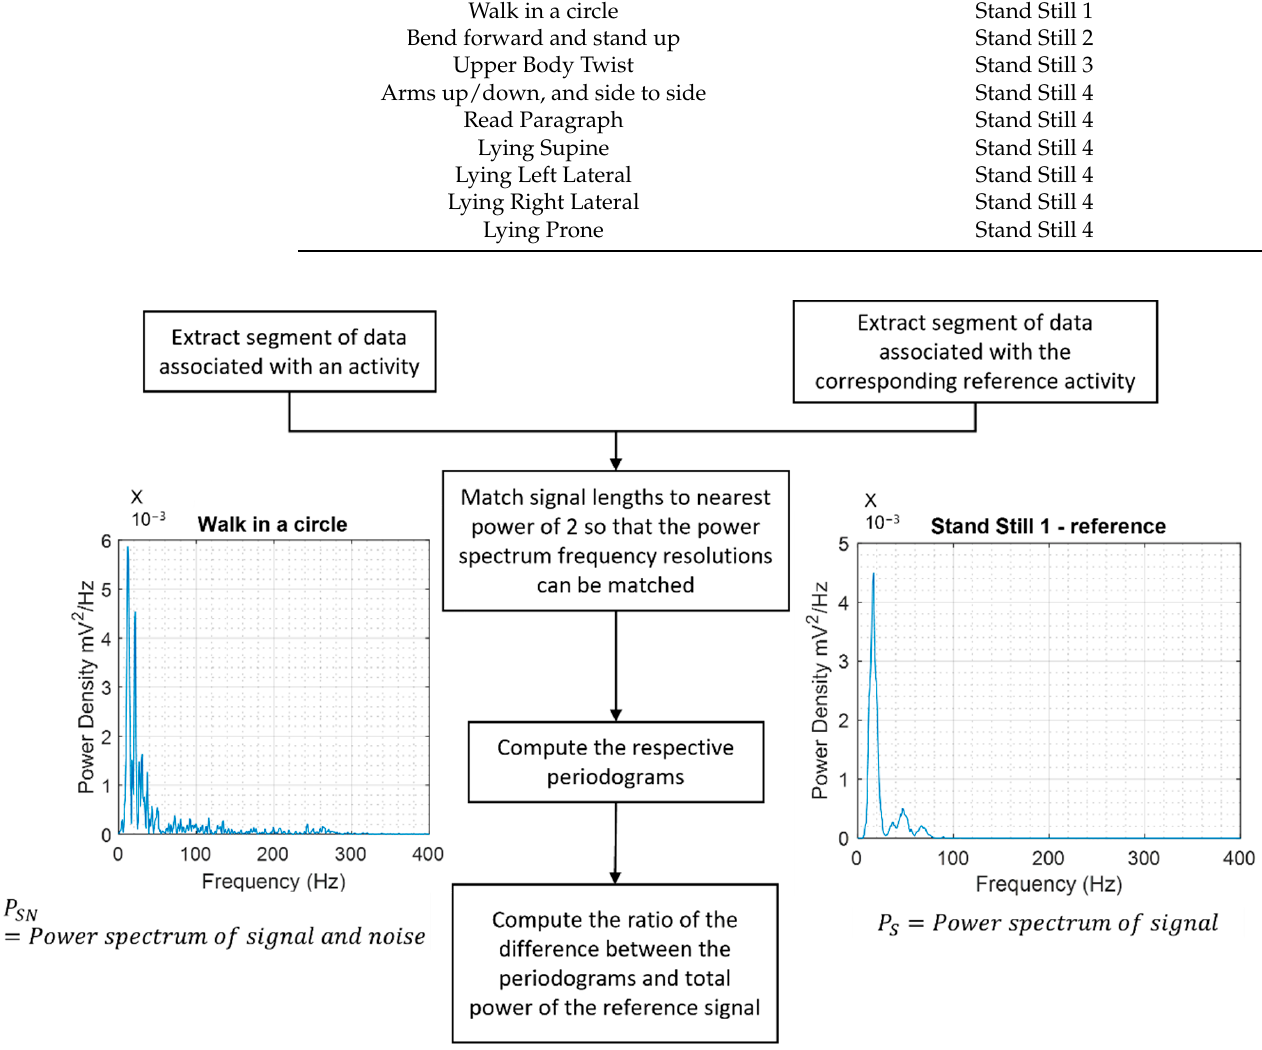
Figure 6. Procedure for estimating noise level of the measured heart sounds for each activity.